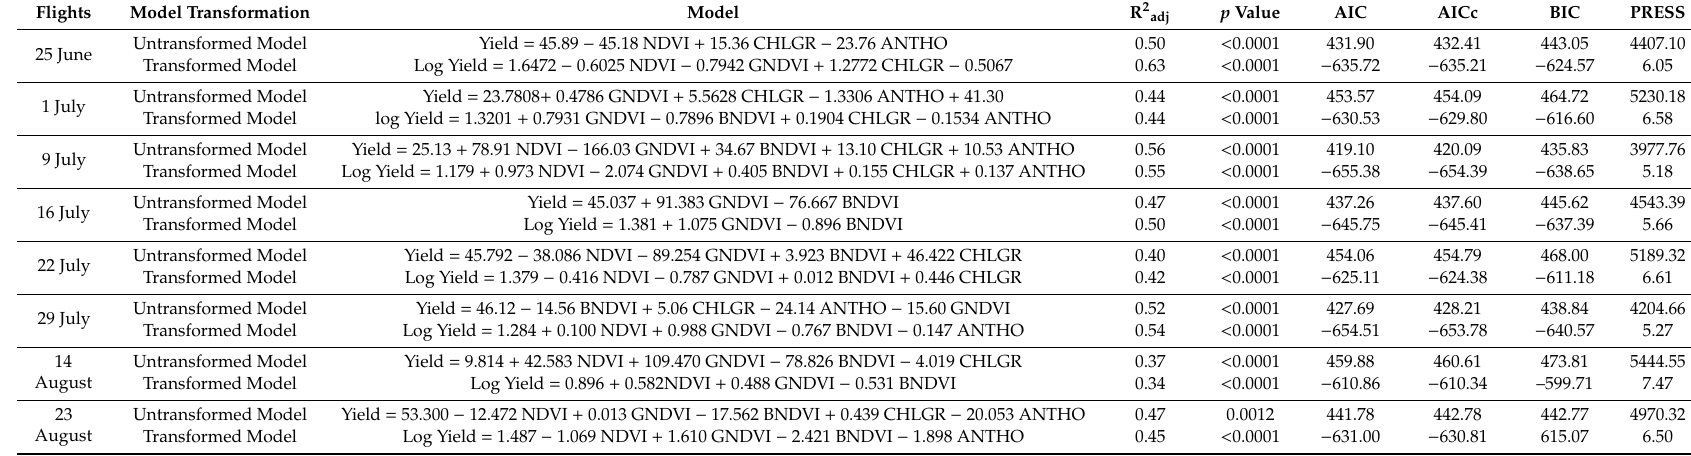
Table 8. Total potato yield models with adjusted coe ffi cient of determination (R 2 adj ), p Value, AIC, AICc, BIC, and PRESS for flight operations. Flights Model Transformation